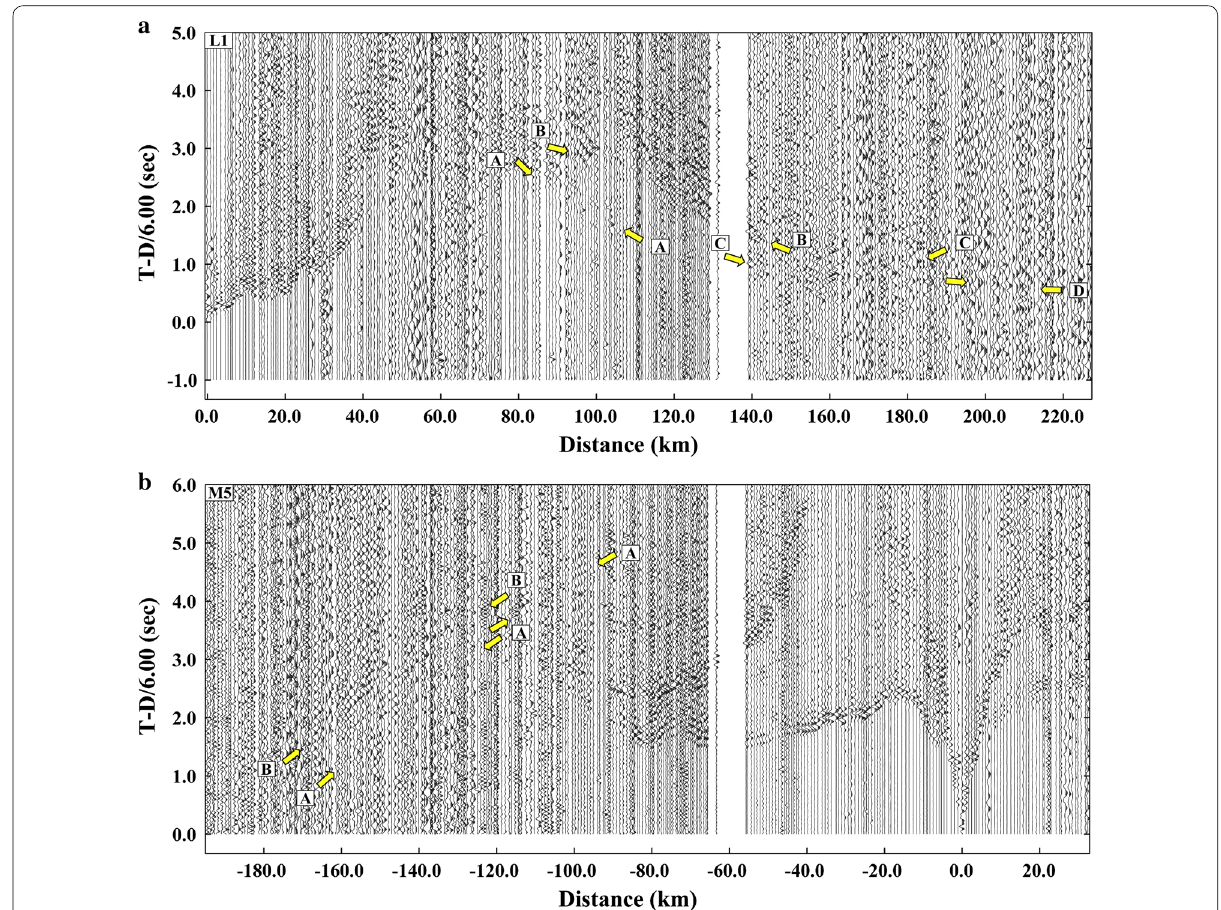
Fig. 6 Record sections from shot L1 and M5. Phases recognized at far offsets (~ 80–200 km) are indicated by arrows. a Record section from shot L1. Interpretations for the phase “A” to “D” are shown in Fig. 7a or b. b Record section from shot M5. Interpretations for the phase “A” and “B” are shown in Fig.